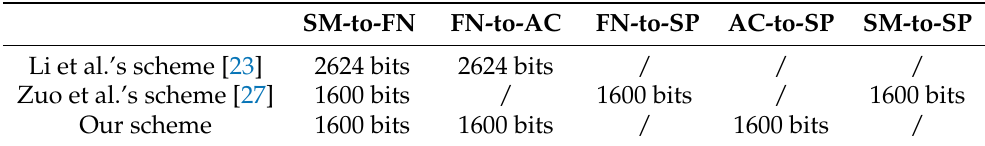
Table 4. Comparison of communication